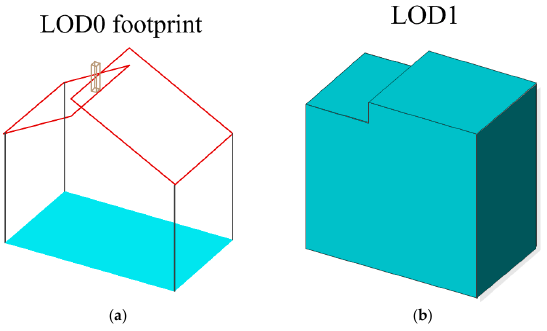
Figure 2. LOD0 footprint ( a ) and LOD1 blocks model ( b ) in CityGML (images: KIT Karlsruhe [5]). Gröger and Plümer [23] described an approach to obtain 3D models of urban GISs based on 2D maps. This approach extends 2D and 2.5D models to a 2.8D model by allowing for overhangs and vertical walls. The 2.8D model is an extension of a digital elevation model (DEM) [29] and allows each (x, y) location to have more than one height value. To guarantee consistency, the faces of an